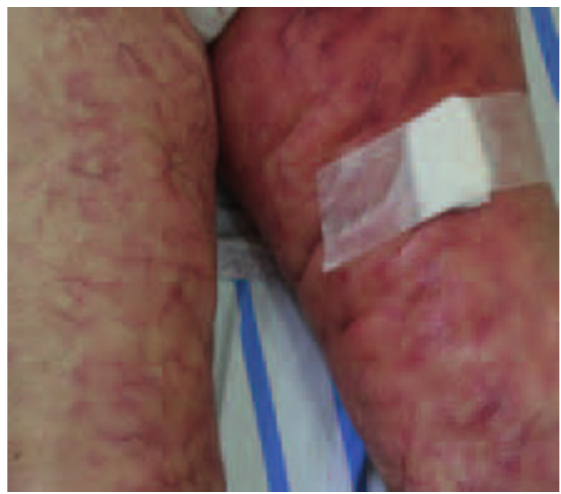
Figure 1. Skin lesions at the time of diagnosis